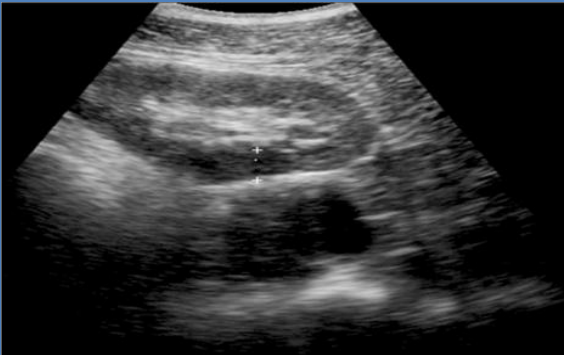
Figure, 4: Percutaneous ultrasonogram of right kidney from right lumbar region of buffalo. 3.5 MHz.